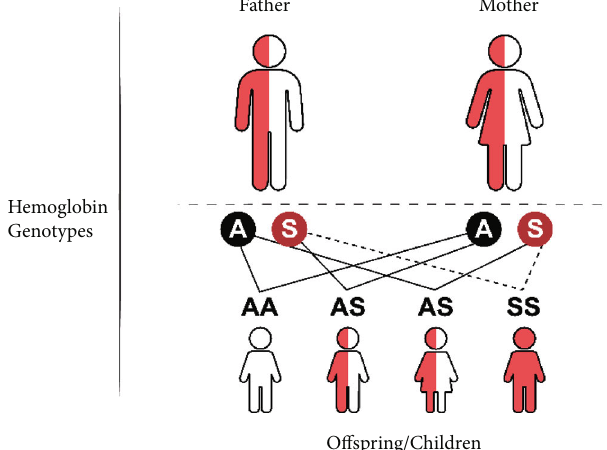
Figure 1: Inheritance of sickle cell disease. In a scenario where both parents have a sickle cell trait (SCT, HbAS), each pregnancy carries a 25% chance of normal o ff spring (HbAA), a 50% chance of o ff spring with SCT, and a 25% chance of o ff spring with sickle cell disease (HbSS).